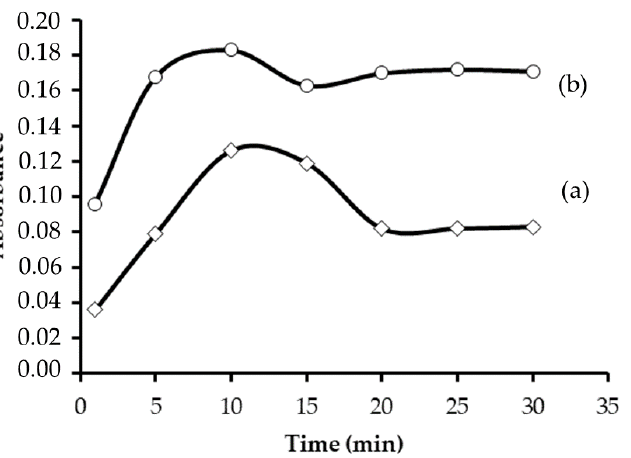
Figure 5. Absorbance’s response of the sensor at 449 nm in the presence of Ni 2+ ( a ) 2 mg L −1 and ( b ) 5 mg L −1 .